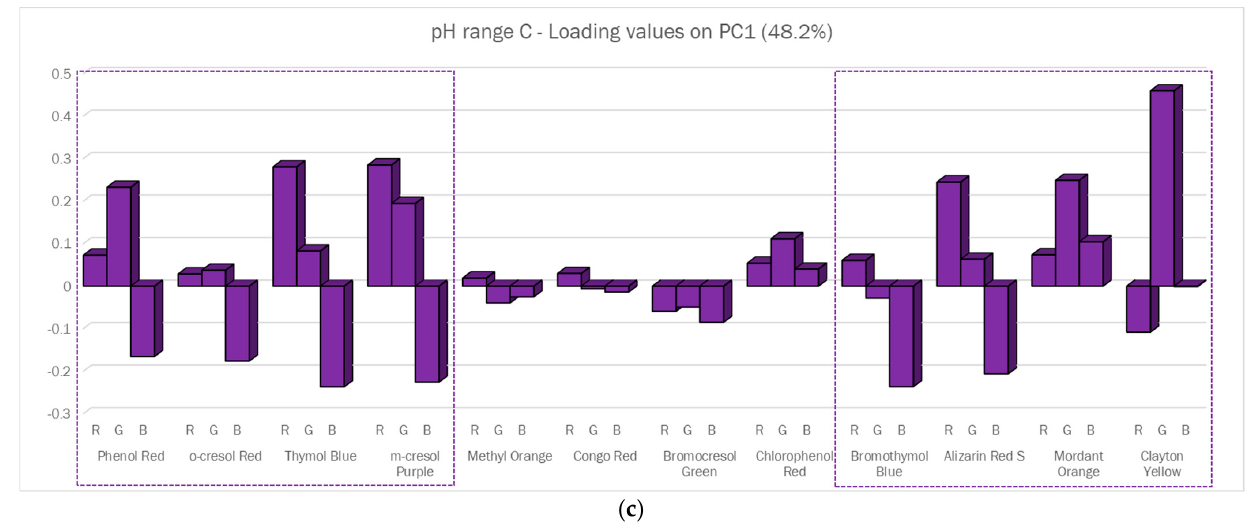
Figure 5. Loading values on PC1 for the PCA models built on the corresponding training samples listed in Table 4 for pH range A ( a ), B ( b ), and C ( c ).